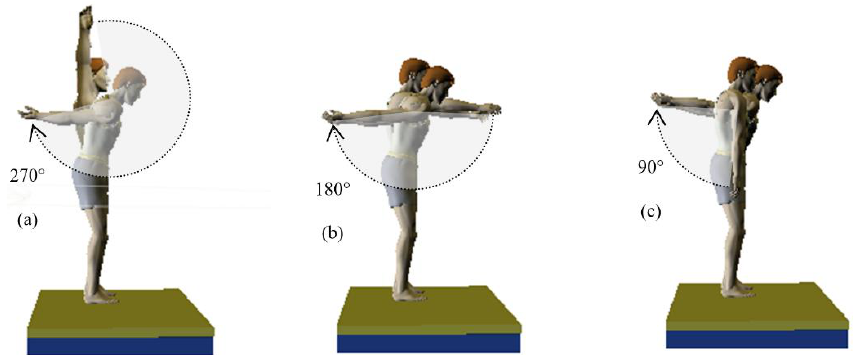
Figure 1. Technical arms swing during the preparatory phase of standing back somersault [23]. ( a ) Arm-swing technique with 270° backswing (SBS 270° ); ( b ) Arm-swing technique with 180° backswing (SBS 180° ); ( c )Arm-swing technique with 90° backswing (SBS 90° ).